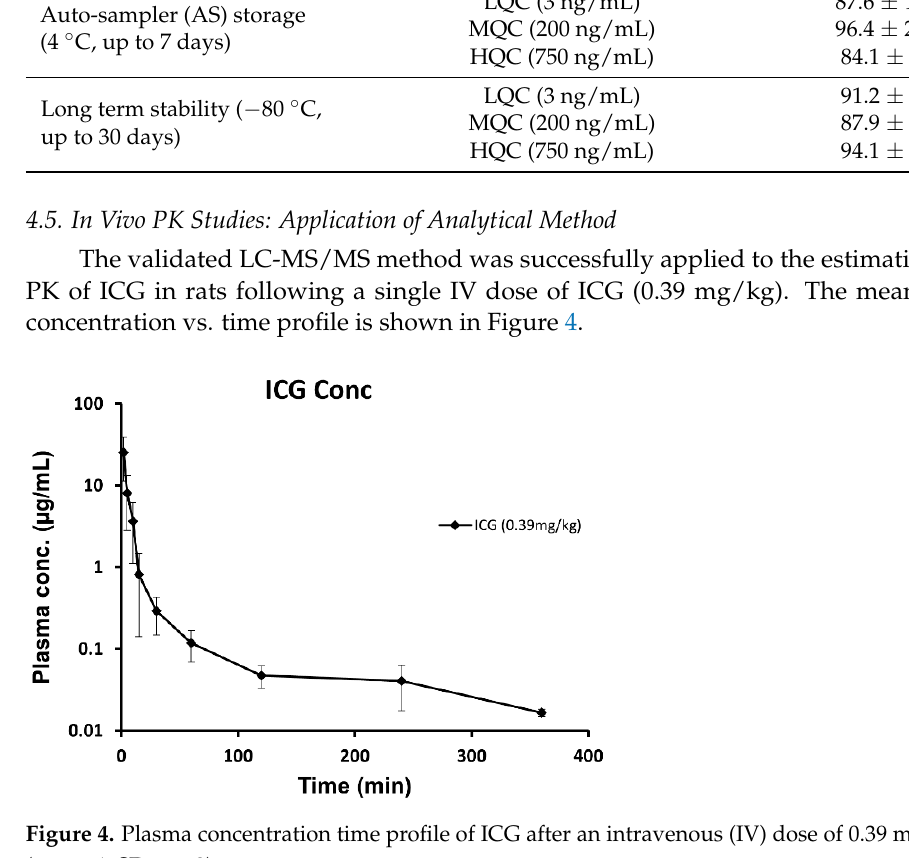
Table 6. Summary of ICG PK parameters after IV (0.39 mg/kg) administration (mean ± SD, n = 3).